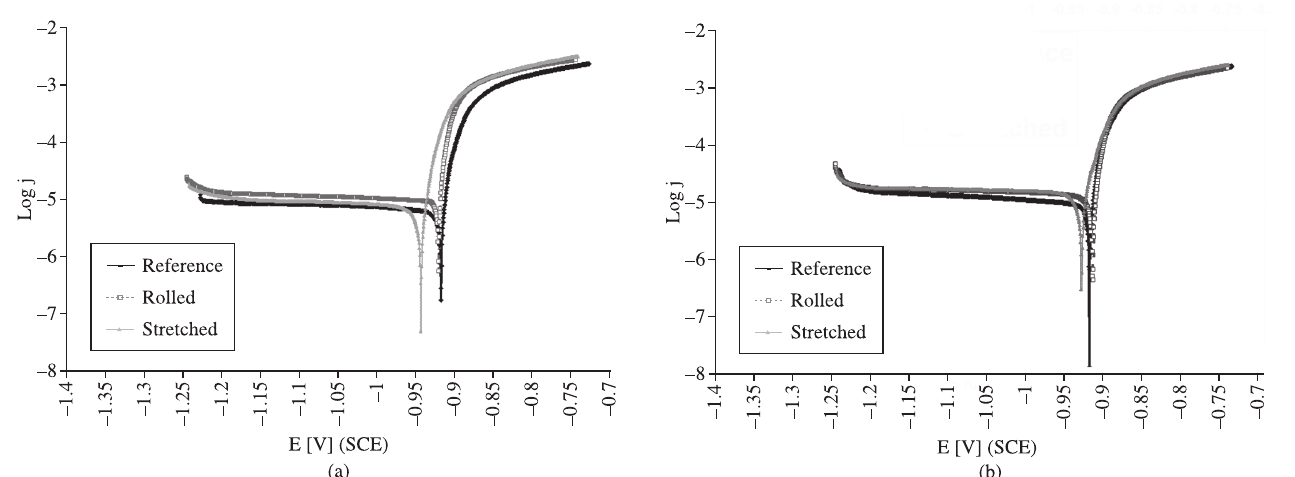
Figure 7. Polarization curves corresponding to two great spangle